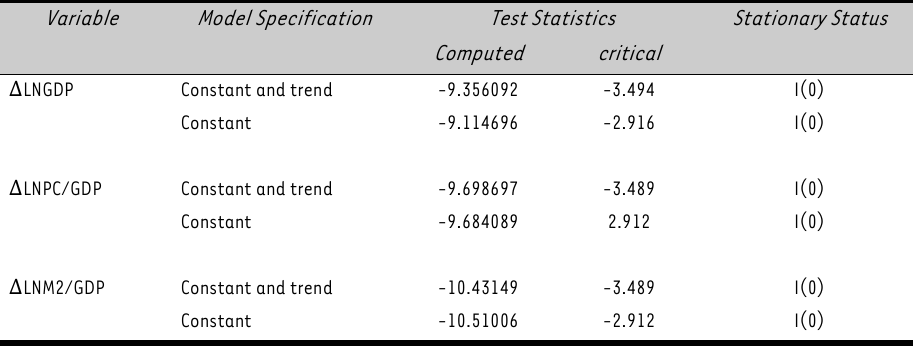
Stationarity test of variables in first difference